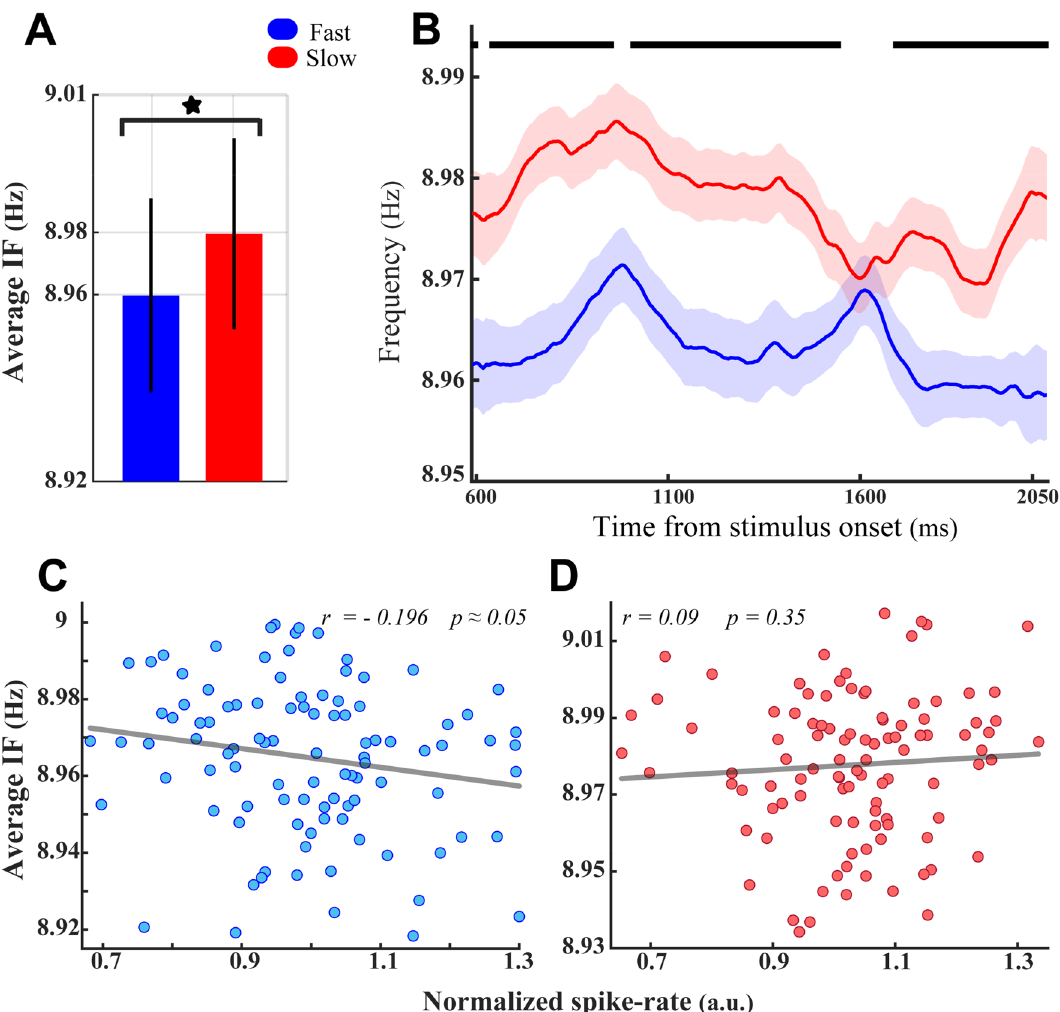
Figure 5. Functional significance of frequency modulation in the theta–alpha band; the effect of frequency modulation on behavioral RTs ( A ) Average theta–alpha frequency of neurons in fast RT trials versus slow RT trials. Despite estimating the IF in the frequency range of 4–13 Hz, the Y-axis was manually adjusted to provide the best illustration of the significant difference between light and dark bars. The asterisk depicts a significant difference in the average IF between the two categories ( p < 7 × 10 −5 , two-sided sign-test). Error bars show the ± 1 STD. ( B ) The temporal dynamics of average IFs, shown in panel A, for the fast versus slow RT trials. Thick-black lines indicate time windows with a significant difference between RT conditions ( p < 0.042, two-sided Wilcoxon rank-sum test with FDR correction for multiple comparisons). Error bars represent the SEM. ( C , D ) The spike rate of each neuron plotted against the average theta–alpha IF of the LFP in fast RT ( C ) and slow RT ( D ) trials. Inset numbers in panels ( C , D ) represent the correlation magnitude ( r , using the Spearman correlation method) and the degree of its significance ( p